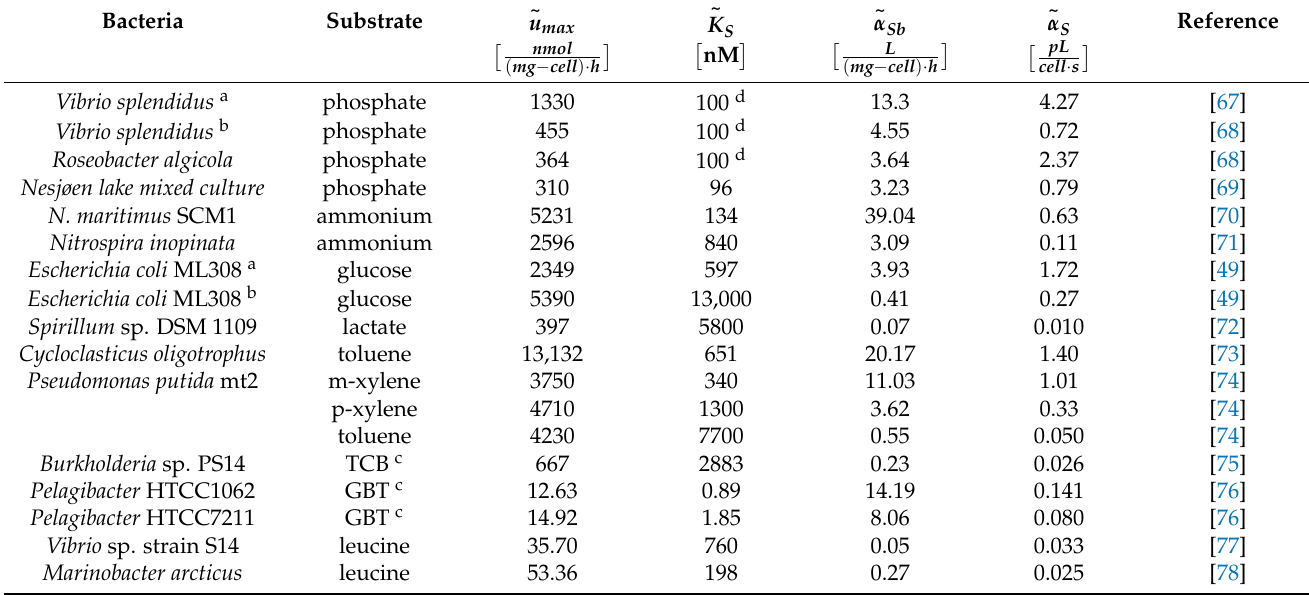
Table 2. Literature review for experimental data delineating the range of the bacterial affinity for organic and inorganic nutrients. Symbols: (cid:101) u max is the maximum uptake rate per cell, (cid:101) K S is the half-saturation constant, (cid:101) α Sb is the per-biomass affinity, and (cid:101) α S is the per-cell